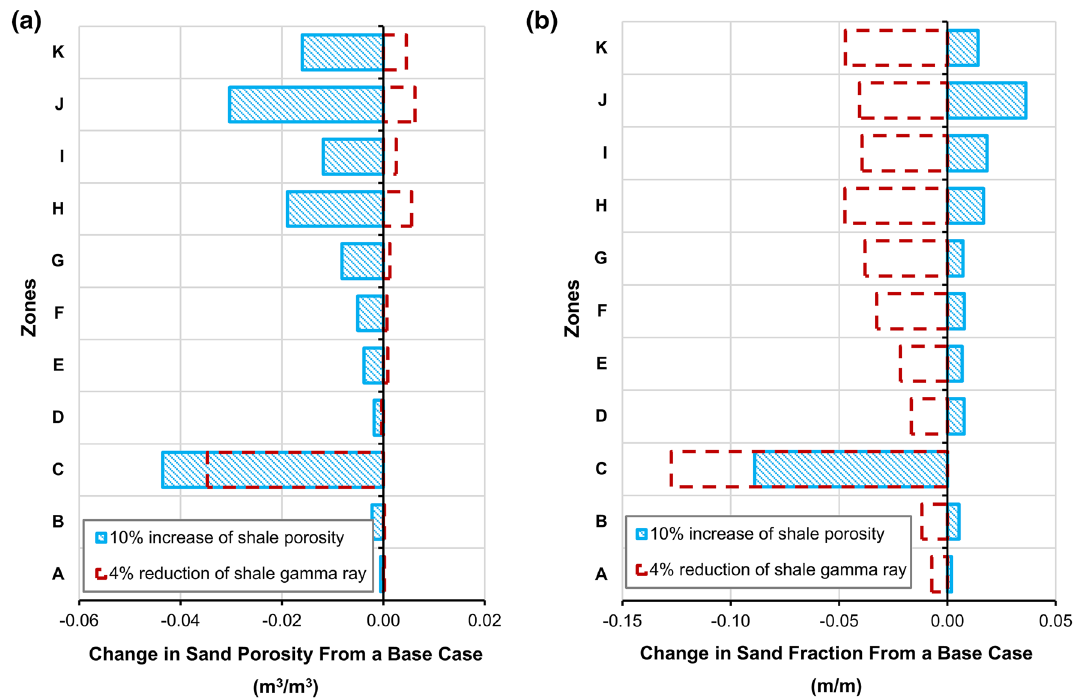
Fig. 8 Sensitivity on a sand porosity and b sand fraction associated with choice of shale endpoint in the Thomas–Stieber